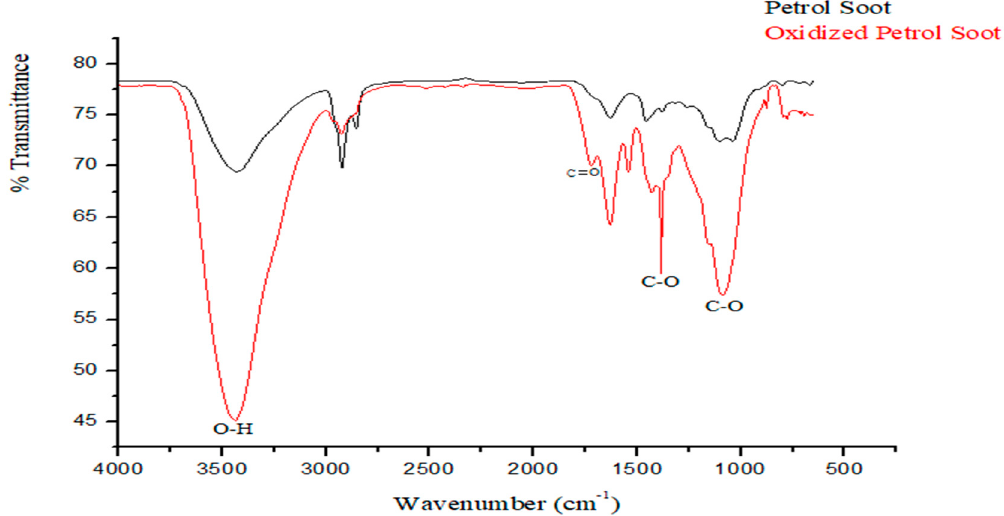
Figure 2. FTIR chromatogram of oxidized petrol soot nanoparticles.